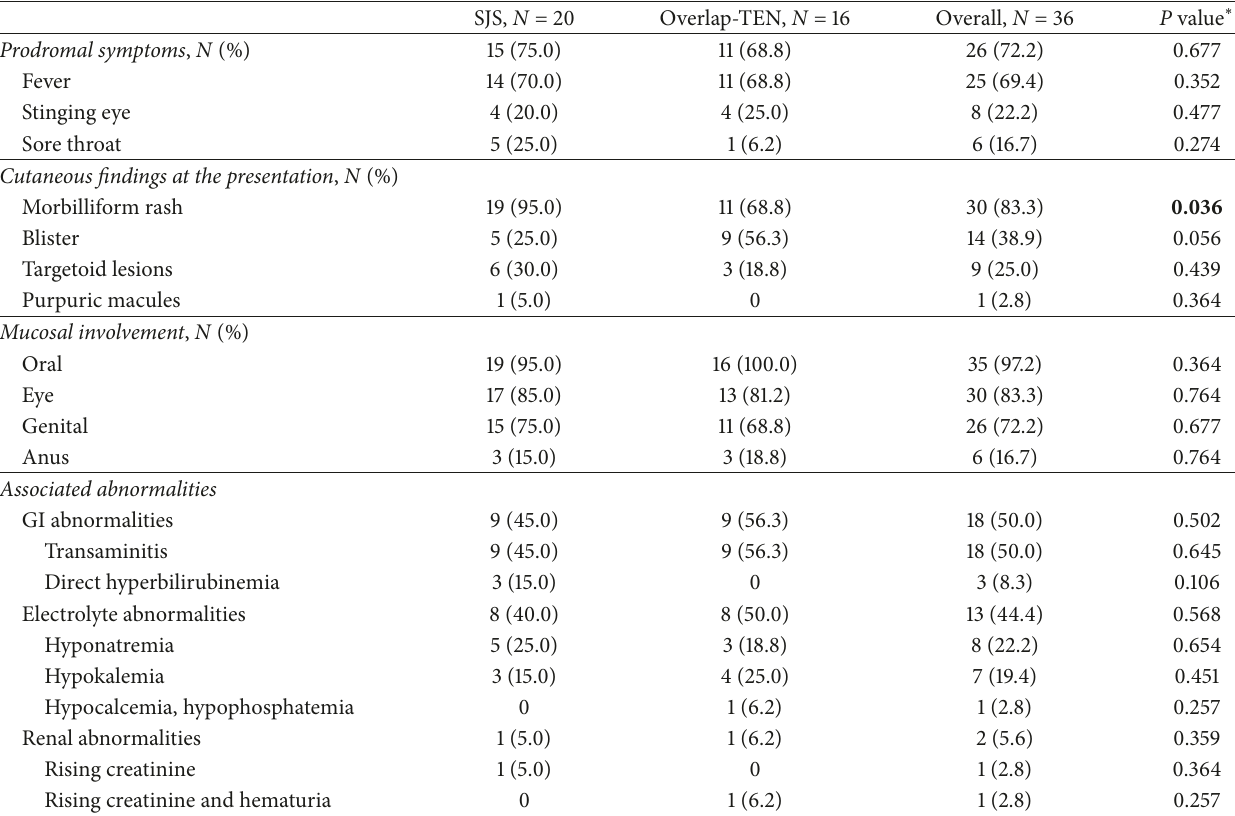
Table 2: Clinical features of patients with Stevens-Johnson syndrome and overlap-toxic epidermal